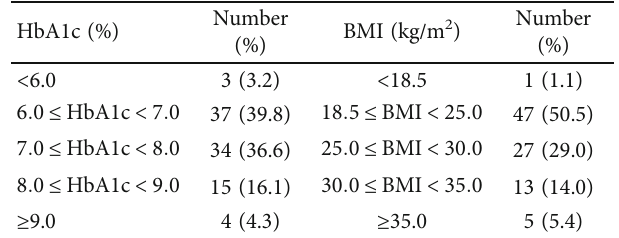
Table 3: Distribution of HbA1c and BMI in patients with type 2 diabetes